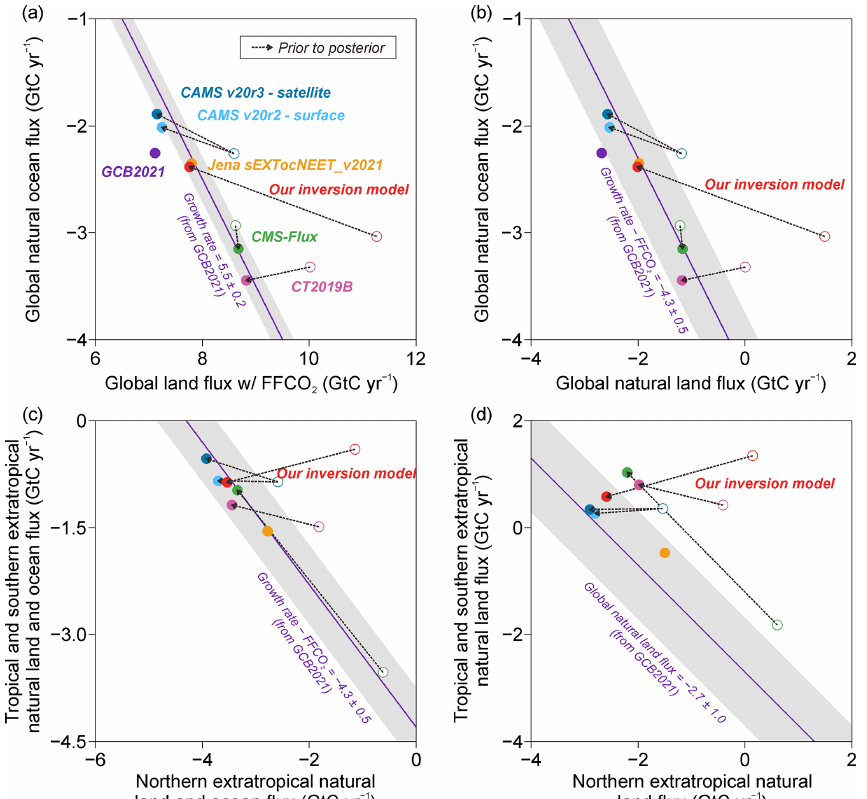
Figure 3. Global carbon flux partitioning schemes between the land and ocean and among different latitudinal bands for 2015–2018. The atmospheric inversion results are represented by solid circles (representing posterior fluxes) and open circles (representing prior fluxes (if any)). The red circles represent the carbon flux estimates derived from our reference inversion results; the blue circles represent the results of the CAMS versions v20r2 and v20r3 (Chevallier, et al., 2005); the orange circles represent the Jena CarboScope version sEXTocNEET_v2021 results (Rödenbeck et al., 2018); the green circles represent the CMS-Flux results (Liu et al., 2021); and the pink circles represent the results of the NOAA CarbonTracker version CT2019B (Jacobson et al., 2020). The purple circles in panels (a) and (b) represent the GCB2021- derived (riverine flux-adjusted) estimates (Friedlingstein et al., 2022). The purple line and equation in each panel represent the sum of the x and y variables derived from GCB2021, and the gray shaded area represents the error equivalent to 1 standard deviation. The purple lines thus have a slope of − 1, and any deviation perpendicular to these purple lines indicates disagreements in the GCB2021 estimates, including the purple circles in panels (a) and (b) derived from the GCB2021 results due to carbon budget